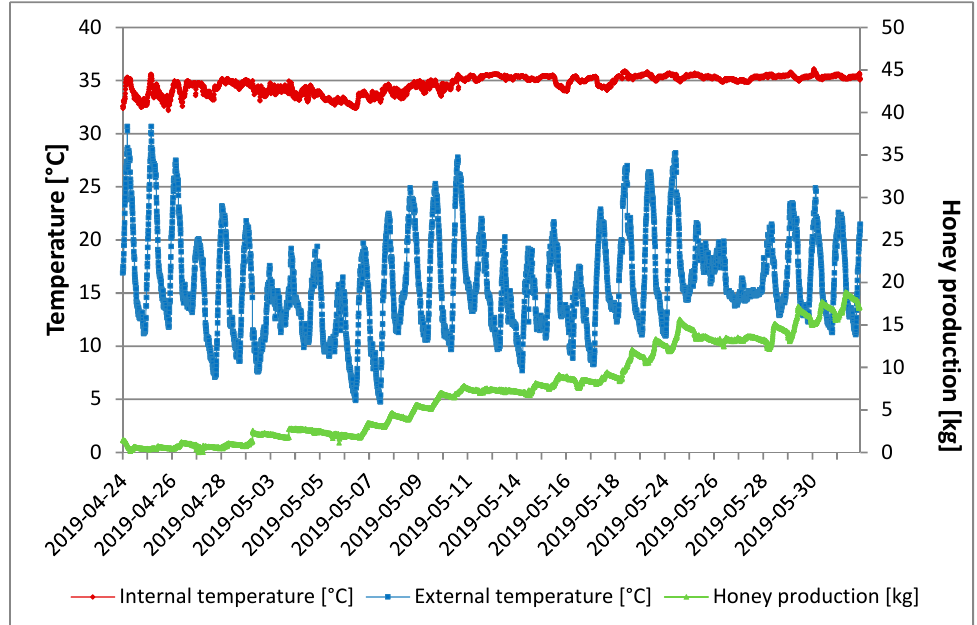
Figure 6. Daily quantity of honey produced as a function of internal and external temperature of the hive (data are the mean of three replicates).